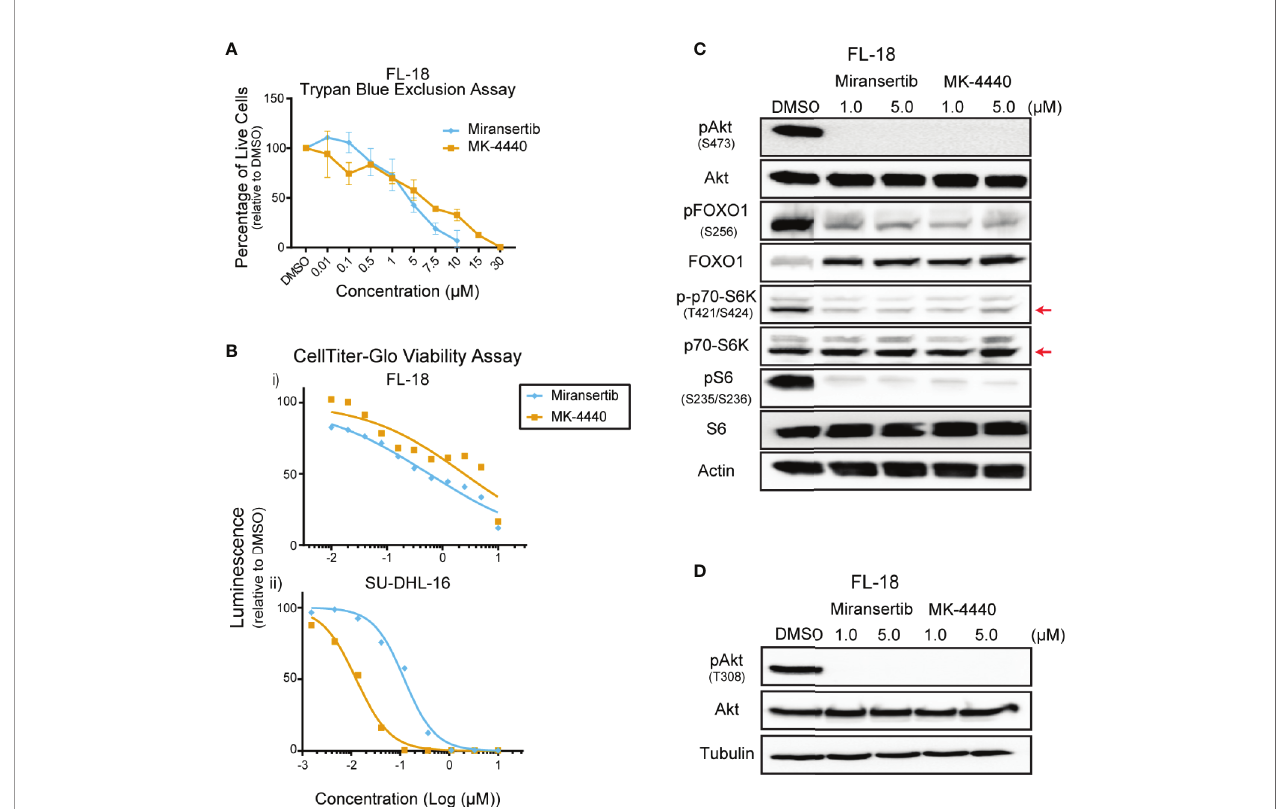
FIGURE 1 | Follicular lymphoma cells are sensitive to Akt inhibition. (A) The follicular lymphoma (FL) cell line FL-18 was treated for 72 h with miransertib or MK-4440, and live cells were counted by excluding dead cells stained with trypan blue. (B) Two FL cell lines, FL-18 (i) and SU-DHL-16 (ii), were treated as in (A) , but viability was measured using CellTiter-Glo. (C) FL-18 cells were treated with 1 or 5 µM of miransertib or MK-4440 for up to 72 h. Immunoblots were performed to determine the levels of phosphorylated (p)Akt (S473), pFOXO1 (S256), p-p70-S6K (T421/S424), pS6 (S235/6), the respective total proteins, and the loading control b -actin. The red arrow points to the p70-S6K isoform. (D) FL-18 cells were treated with 1 or 5 µM of miransertib or MK-4440 for 24 h. Immunoblots were performed to determine the levels of pAkt (T308), Akt, and the loading control a